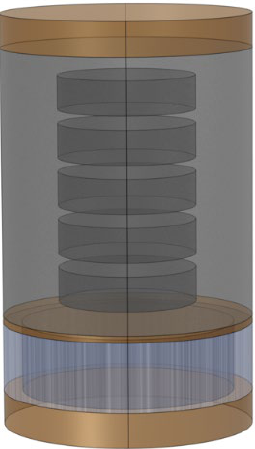
Figure 10. Simplified axisym 2D model.